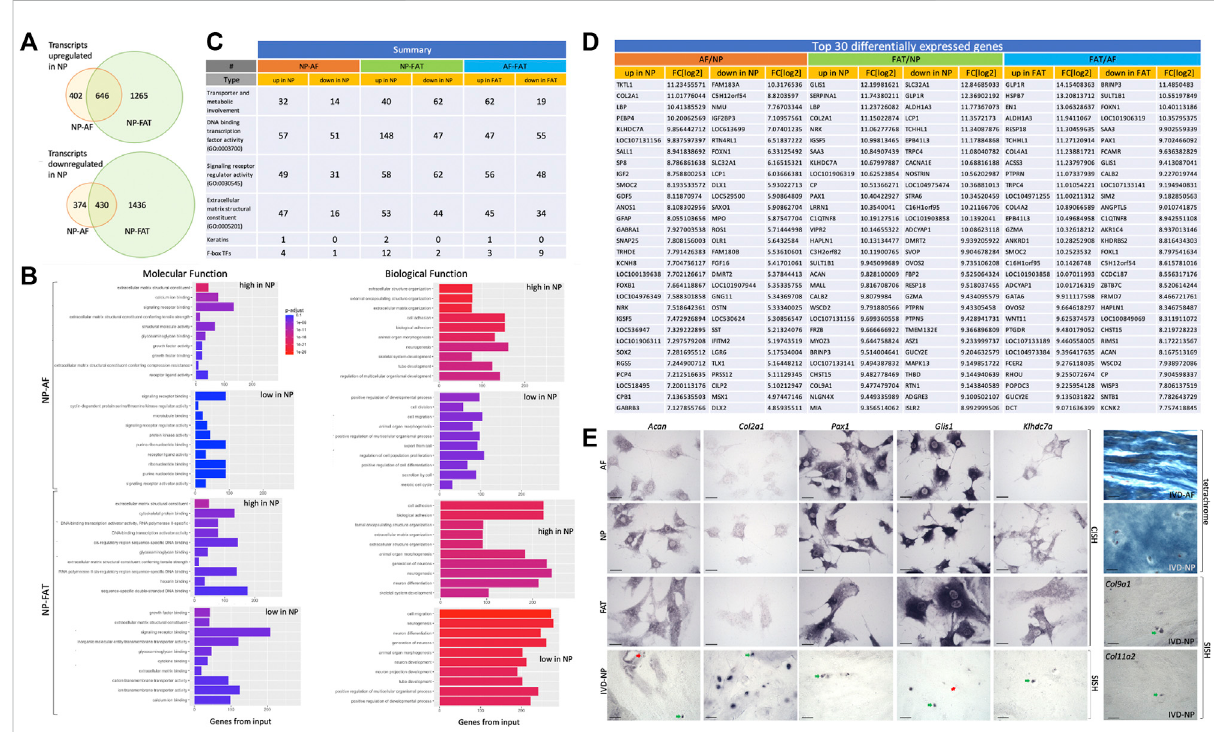
FIGURE 4 Overview of differentially expressed transcripts from annulus fi brosus (AF), nucleus pulposus (NP), and subcutaneous adipose (FAT)-derived primary cells (A) . Bar graphs indicate the 10 top categories after functional enrichment for molecular or biological functions. Colors indicate the Benjamini – Yekutieli adjusted p -values. (B) . Summary of RNASeq results (C) . Top 30 differentially expressed transcripts (D) and validation of selected targets through RNA in situ hybridization and alkaline phosphatase reporter gene expression on cultured cells (CISH) and sections through the nucleus pulposus of the IVD (SISH) where green arrows point to positive and red arrows to negative cells. Tetrachrome staining of IVD sections providesECMhistologyforreference (E) .Scalebarrepresents50 μ m.Cellswereisolatedfromasingledonortoavoidthegenotypeeffect.Cellswere analyzed as three replicates for AF and NP and two replicates for FAT